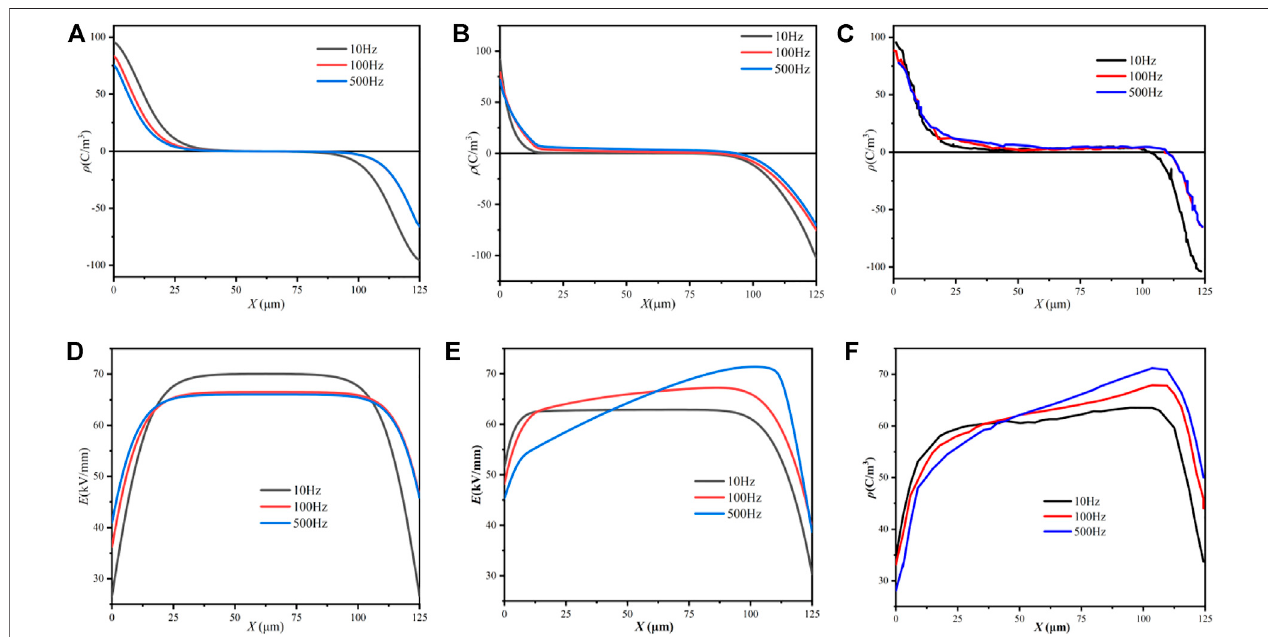
FIGURE 5 | Comparison between experimental results and different simulation models with different frequency : (A) space charge distribution of BCT model, (B) spacechargedistributionofHVCTmodel, (C) experimentalresultsofspacechargedistributionin(Renetal.,2020), (D) electric fi eldofBCTmodeldistribution, (E) electric fi eld distribution of HVII model, (F) experimental results of electric fi eld distribution in (Ren et al., 2020)